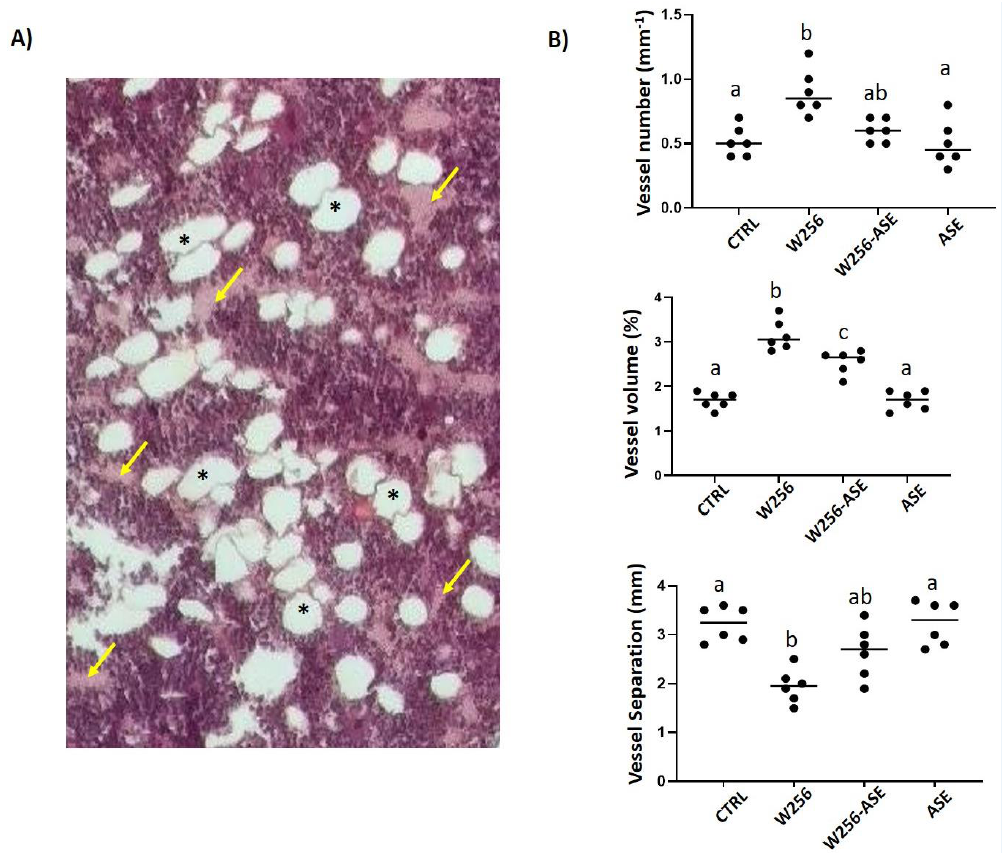
Figure 6. ( A ) Bone histological section of the distal operated femur from W256 rat 20 days after surgery. The cross-section was realized close to the tumoral foci, just below the growth plate. The section exhibits a high number of blood vessels (arrows) and adipocytes (asterisks) surrounded by a polymorph aspect of hematopoietic lineage and Walker 256/B cells. Original magnification ×200. ( B ) Angio-architecture of the distal operated femurs from CTRL, W256, W256-ASE and ASE 20 days after surgery. The angioarchitecture was assessed by two-dimensional (2D) histomorphometric analysis. Values represent mean ± SD. Groups with different letters exhibit significant statistical difference at least * p < 0.05 following one-way ANOVA and Newman–Keuls post hoc tests.